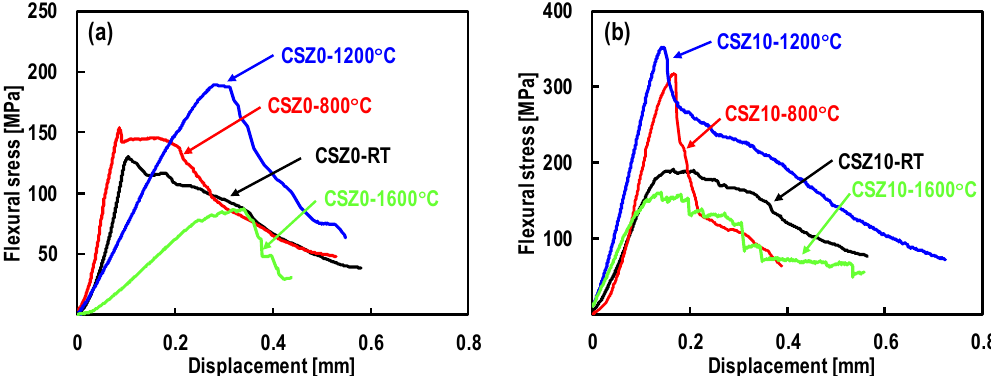
Figure 5. Typical stress-displacement curves of composites under vacuum at temperatures ranging from RT to 1600 °C: ( a ) CSZ0; ( b ) CSZ10.